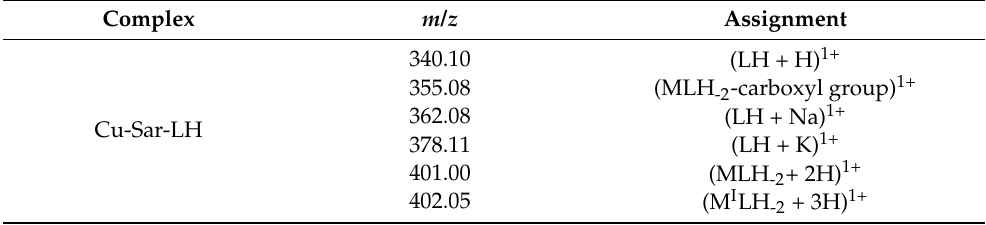
Table 4. Structural assignments of m / z base peaks that were found in the ESI-MS spectrum for Cu-Sar-LH at pH 5 (positive mode) with a 1:1 ratio and concentration of 1 mM for Sar-LH and 0.7 mM for copper(II) in aqueous